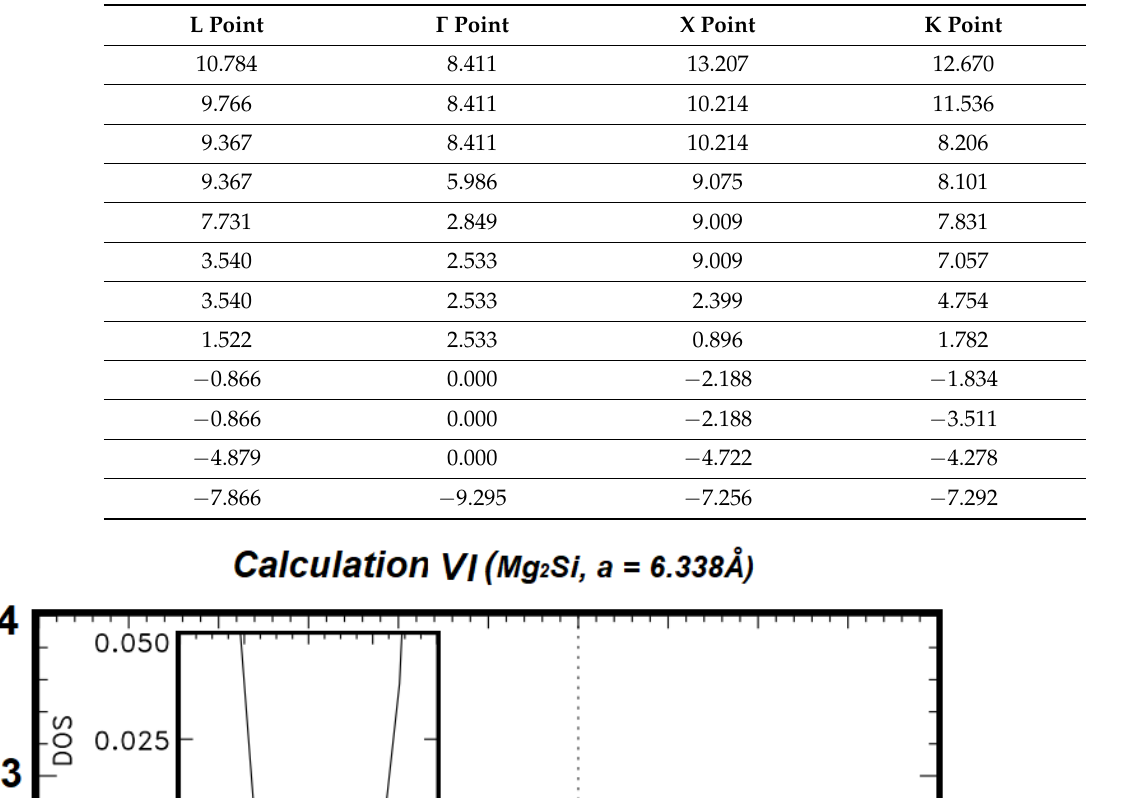
Table 4. Calculated eigenvalues (in eV) at high-symmetry points for cubic Mg 2 Si, as obtained from Calculation VI, with the optimal basis. The room temperature experimental lattice constant is 6.338 Å.